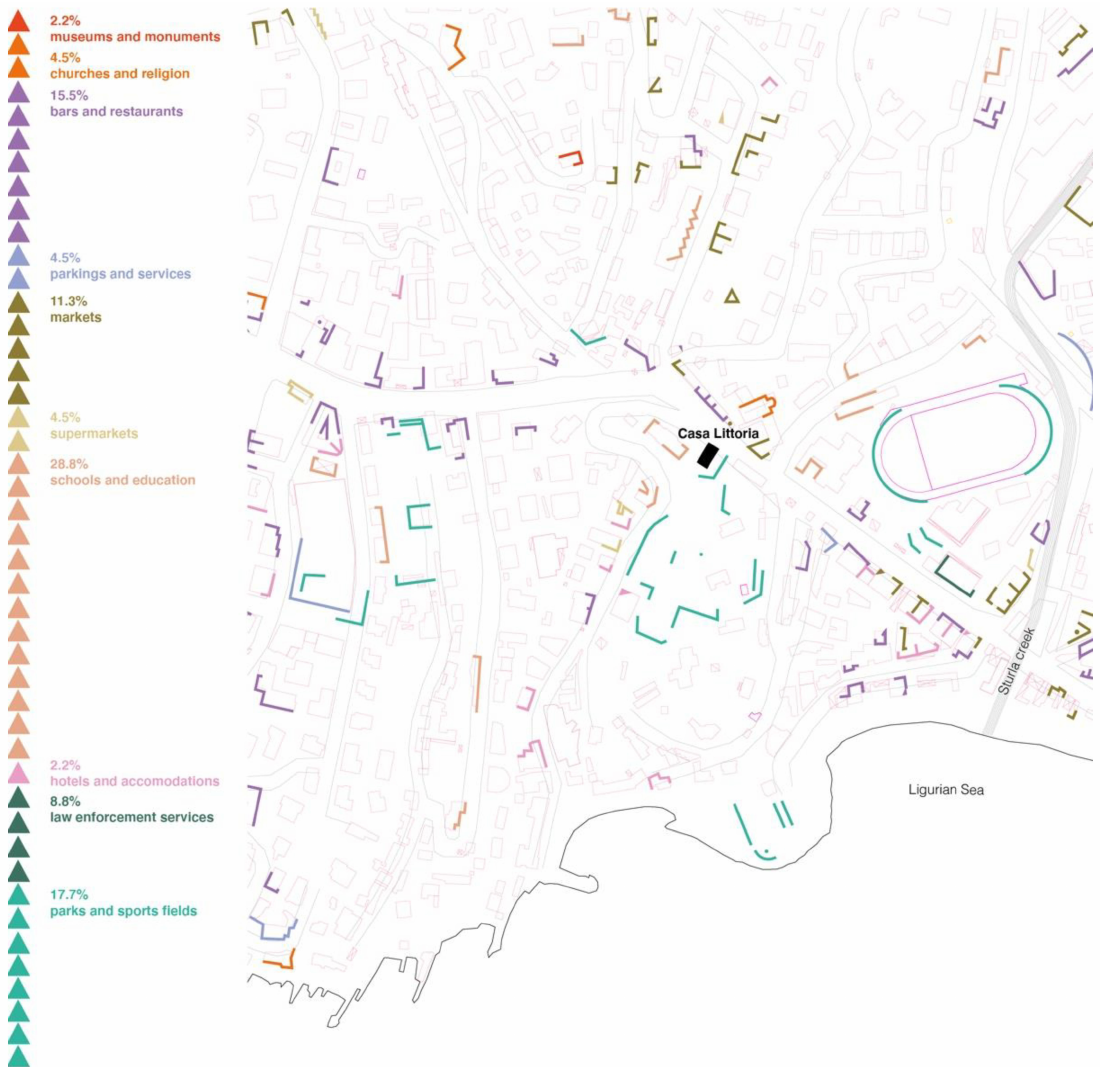
Figure 4. Functions and services in the case study